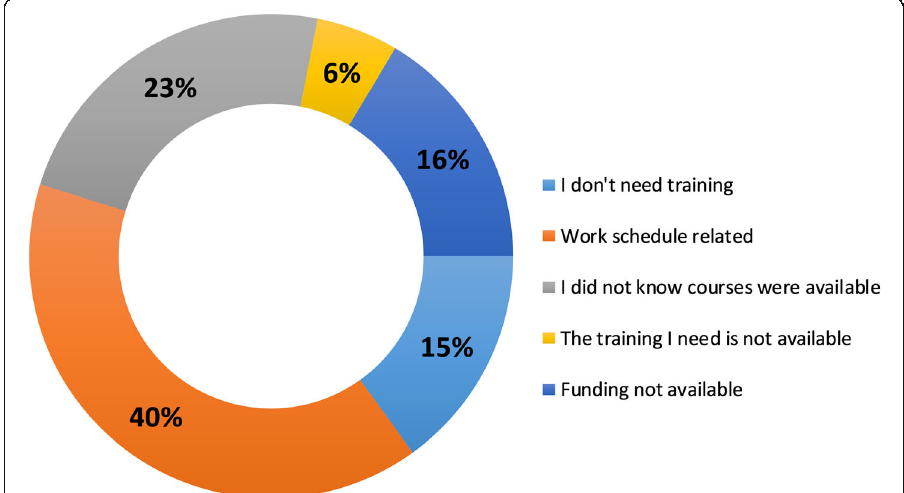
Fig. 3 Barriers to training as identified from the online